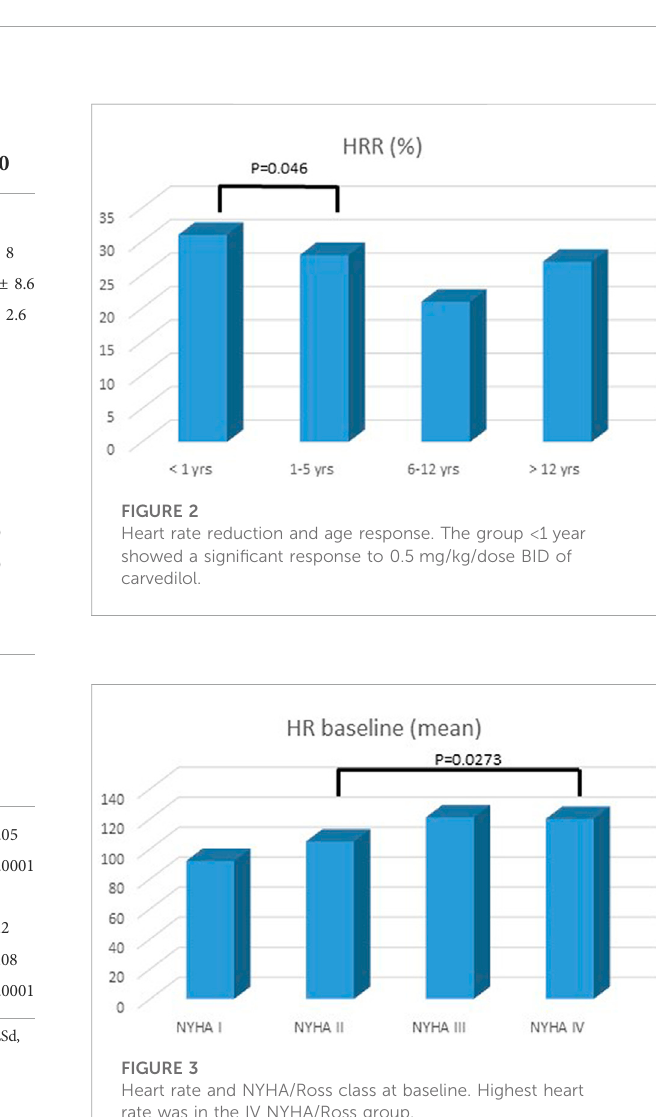
(Table 2). No gender related differences in HRR have been identi fi ed